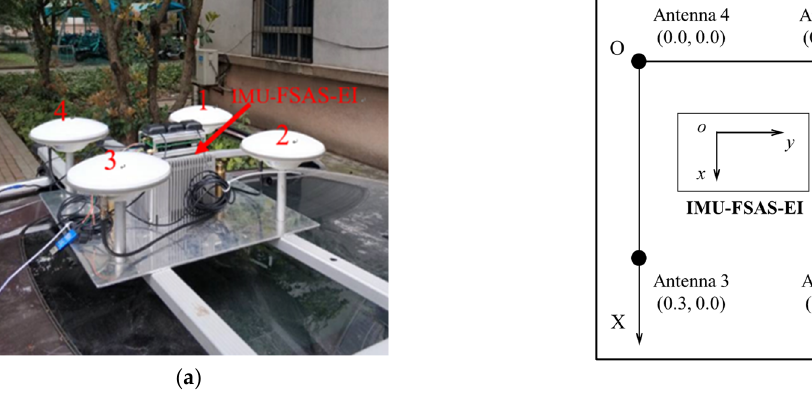
Figure 4. The four-antenna platform: ( a ) Real photos; ( b ) schematic diagrams.